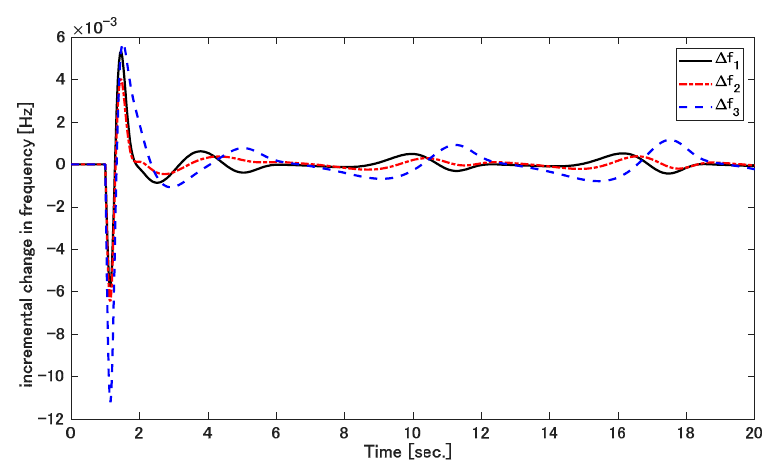
Figure 12. Frequency deviation of three-area power system without a wind plant.